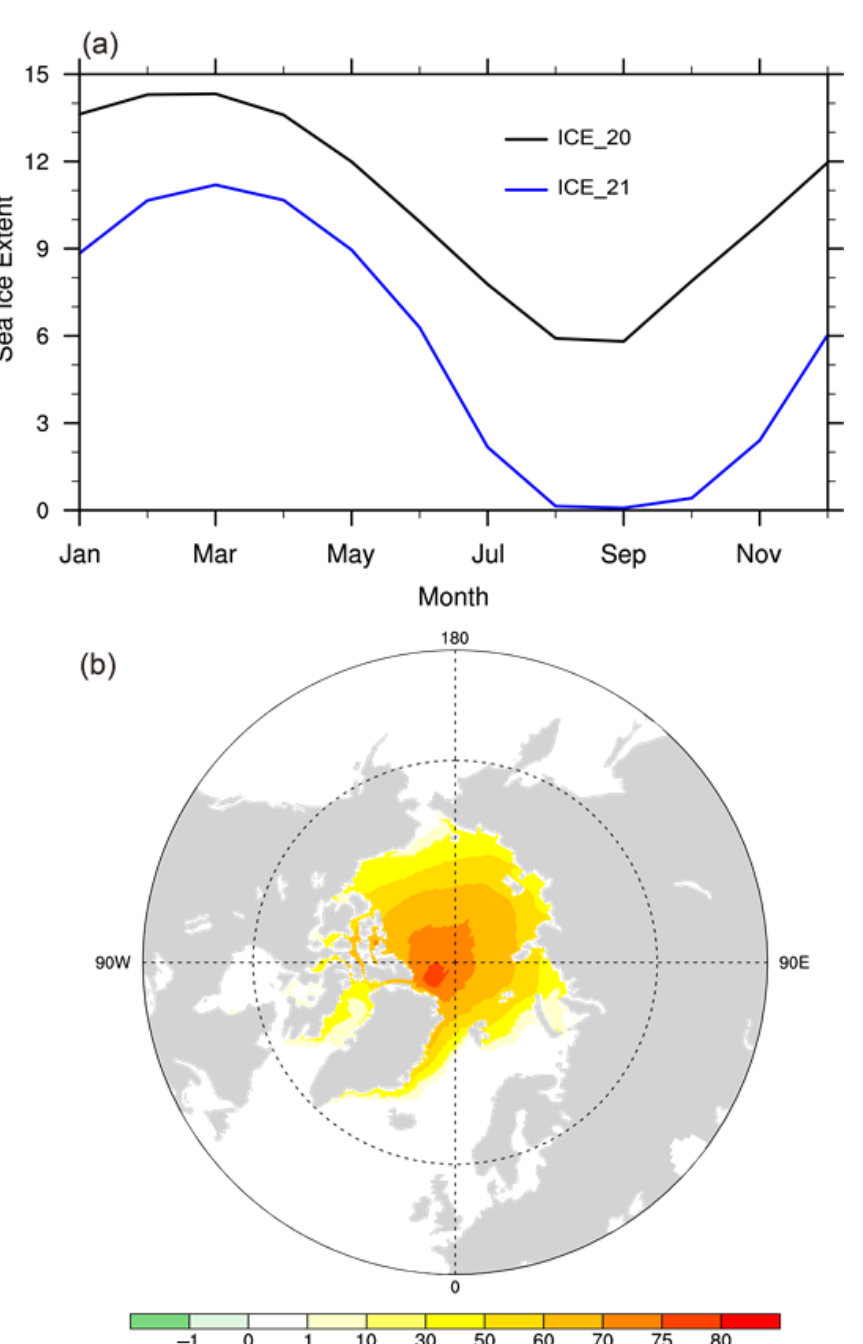
Figure 1. ( a ) Monthly Arctic sea ice extent (10 6 km 2 ) in the late 20th century (1980–1999) under historical radiative forcing (the black line) and the late 21st century (2080–2099) under RCP8.5 radiative forcing (the blue line). ( b ) The longwave radiative flux (W/m 2 ) artificially added to the sea ice model in September in ICE_21 compared to ICE_20. The direction of longwave radiative flux is downward.